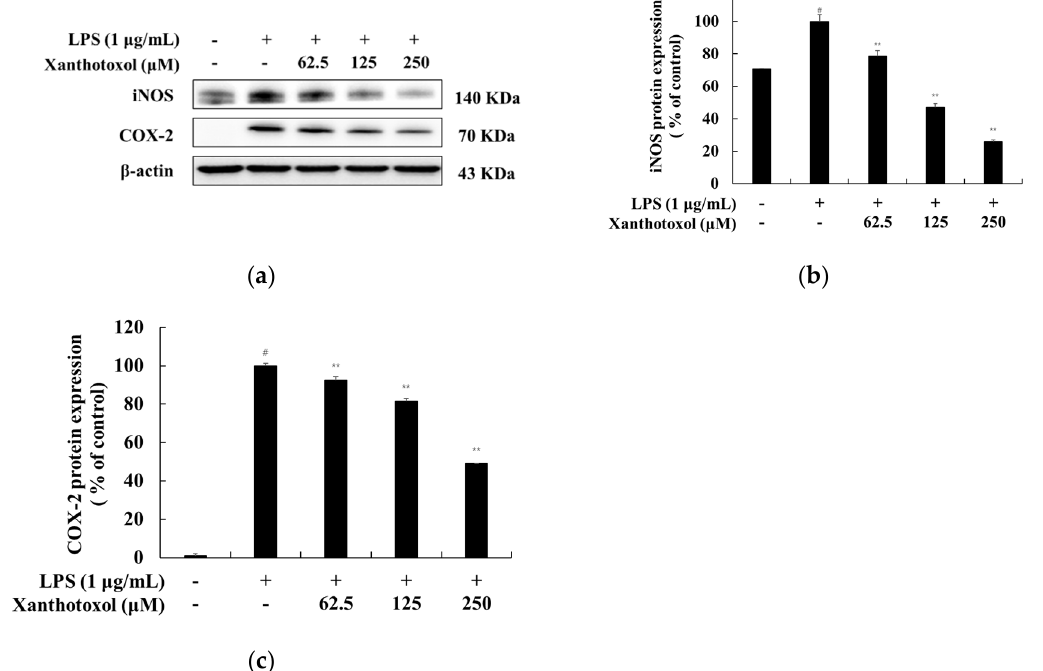
Figure 5. Effect of xanthotoxol on the protein expression level of iNOS and COX-2 in LPS-induced RAW 264.7 cells. The cells were treated with xanthotoxol (62.5, 125, and 250 μ M) and LPS (1 μ g/mL) for 24 h. ( a ) Western blotting results, and protein expression of ( b ) iNOS and ( c ) COX-2. β -actin was used as a loading control. The results are presented as the mean ± SD from three independent measurements using the Image J. # p < 0.01 vs. untreated control group. ** p < 0.01 vs. LPS